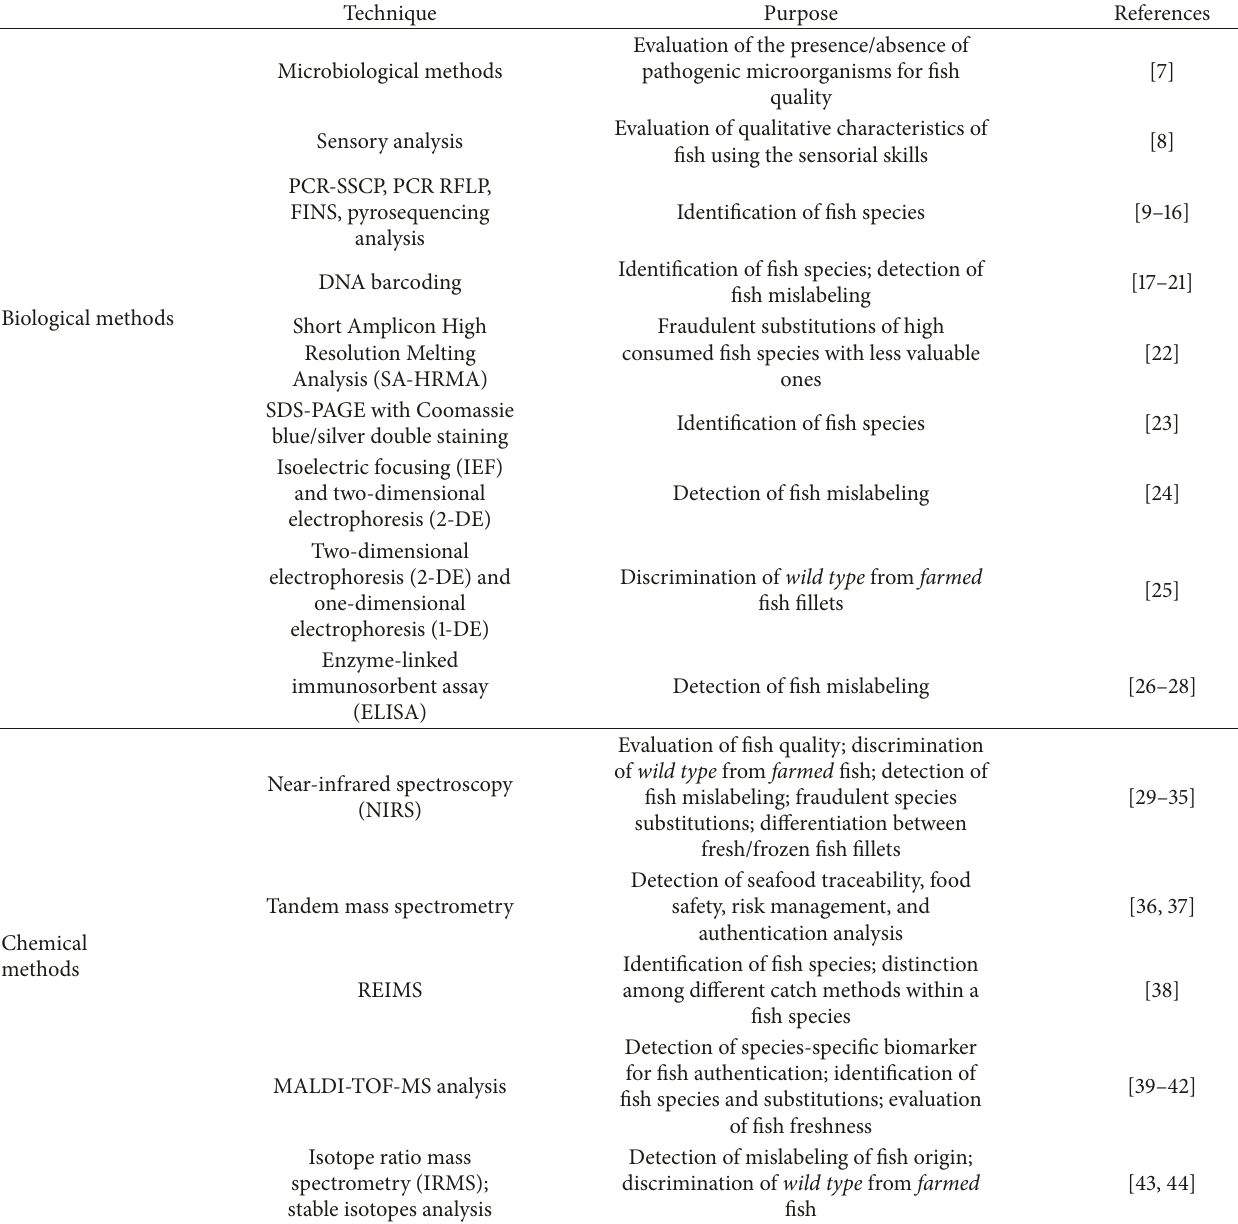
Table 2: Overview of biological and chemical analytical methods developed to assess fish